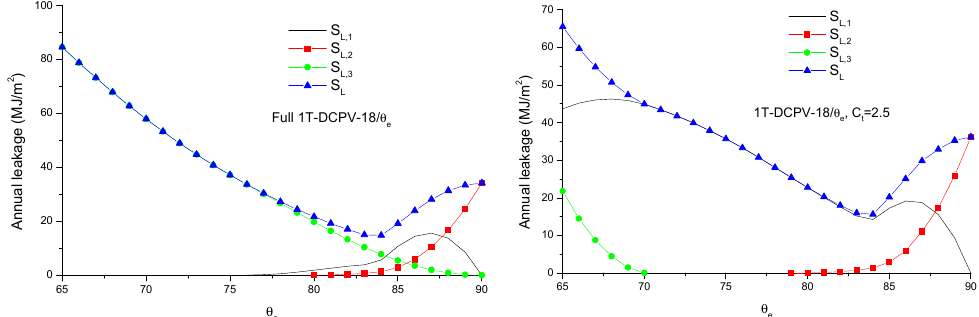
Figure 13. Variations of annual leakage loss with θ e for 1T-DCPV-18/ θ e . Figure 13 . Variations of annual leakage loss with e